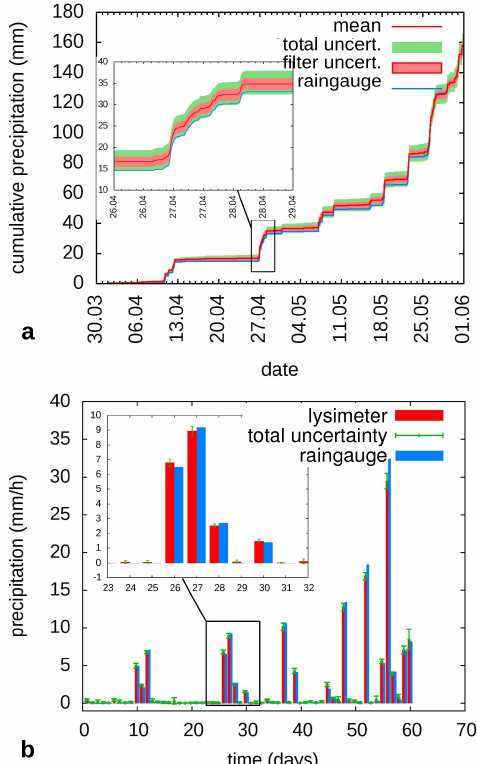
Figure 8. The calculated precipitation with its uncertainties as cu- mulative precipitation (a) and daily precipitation (b) . The total un- certainty is the sum of the estimated filtering uncertainty and the standard deviation of the different measurements on the 18 lysime- ters.